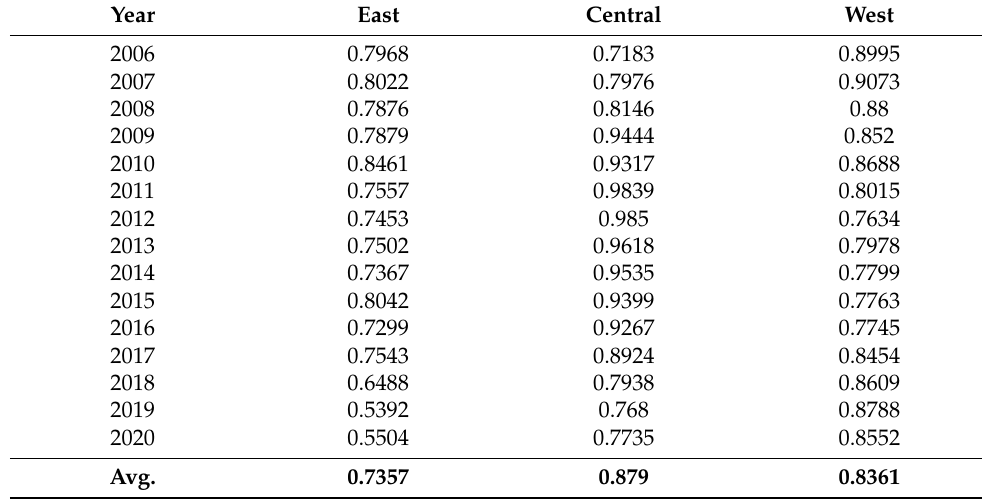
Table A3. Group frontier of all three regions over the period 2006–2020.